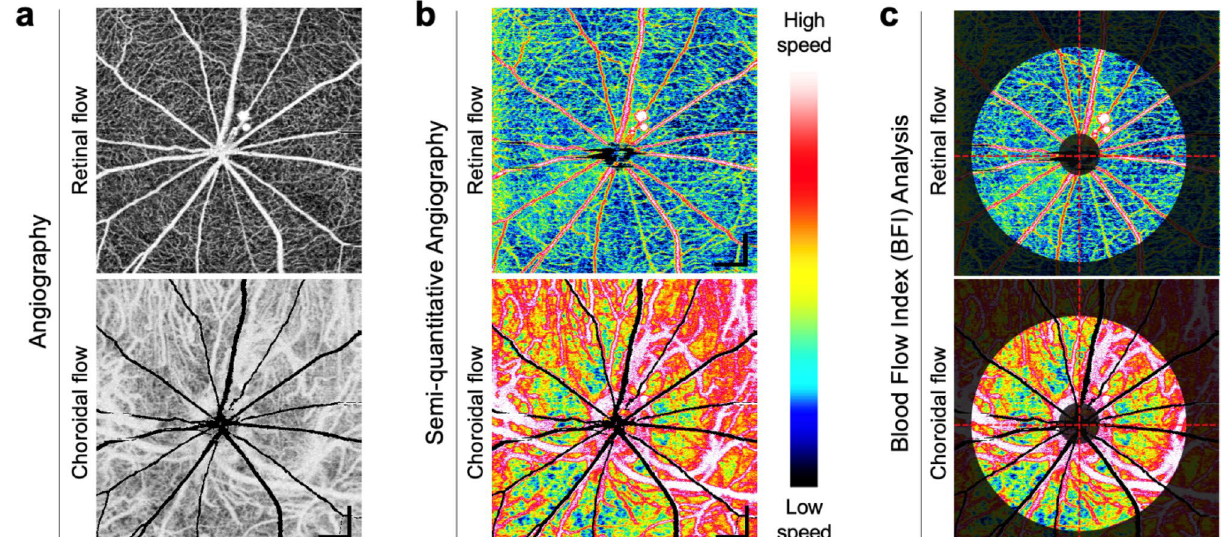
Figure 1. Multi-Interscan-Time OCT Angiography and Blood flow index (BFI) analysis. ( a ) Shows conventional en face OCT angiograms of the retinal and choroidal layers visualizing vascular morphology. ( b ) Shows semi-quantitative OCT angiograms providing color-coded display of relative flow speeds in the capillaries of the retinal and the choroidal layers using multi-interscan-time OCTA. Retinal and choroidal en face angiograms were generated by segmenting the line corresponding to the RPE-Bruch membrane complex and projecting, respectively. Shadow artifacts caused by thick retinal vessel in the choroidal layer are shaded in black. The BFI’s for the retinal and the choroidal flows were calculated in the donut-shaped area covering 0.5 mm through 2.5 mm distance from center of the optic nerve head ( c ). Scale bars: 400